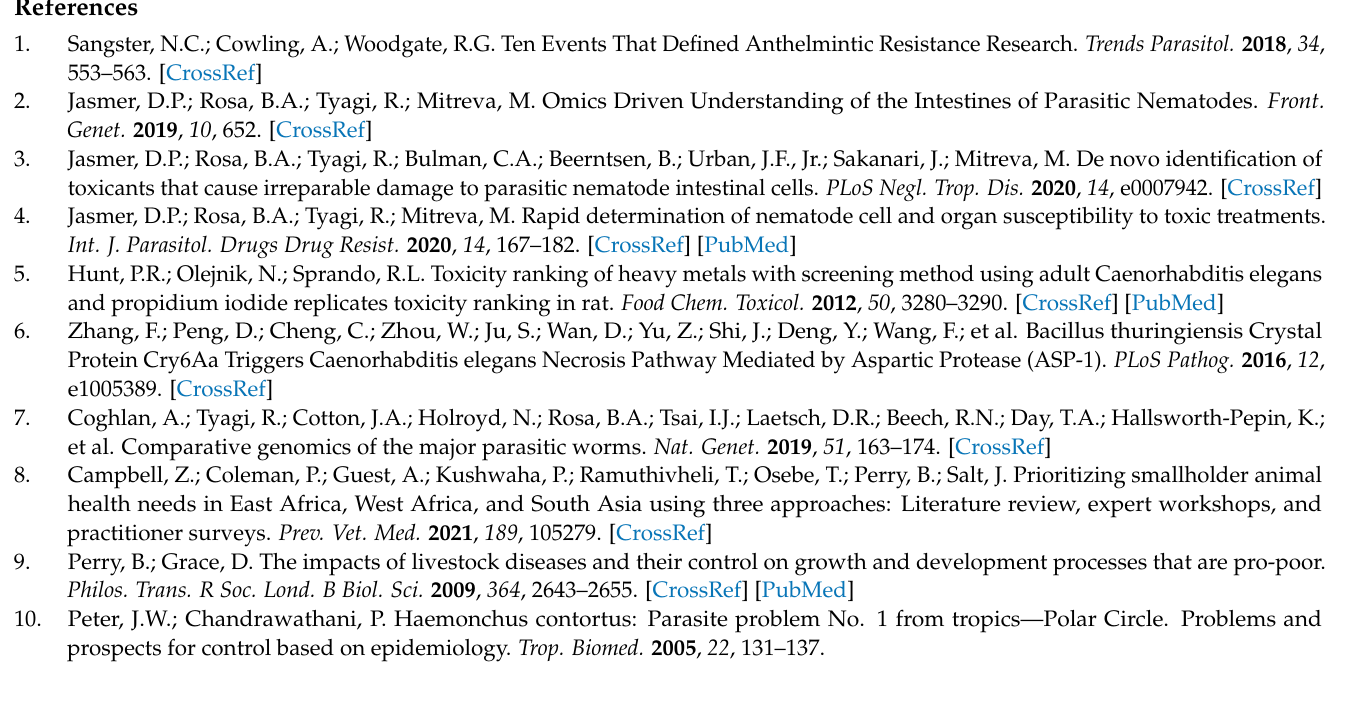
Figure S2: Association between motility inhibition and PI staining for each of the seven NITs. All NITs were applied with a concentration of 500 µ M except Staurosporine at 25 µ M. PI was applied 4 h pre-treatment and included throughout the treatment period; Supplementary Table S1: RNA-seq data, including (A) Metadata and read count statistics for all RNA-seq samples and (B) Functional annotations, mapped RNA-seq read counts, FPKM relative expression values, and DESeq2 differential expression results for all genes and all RNA-seq